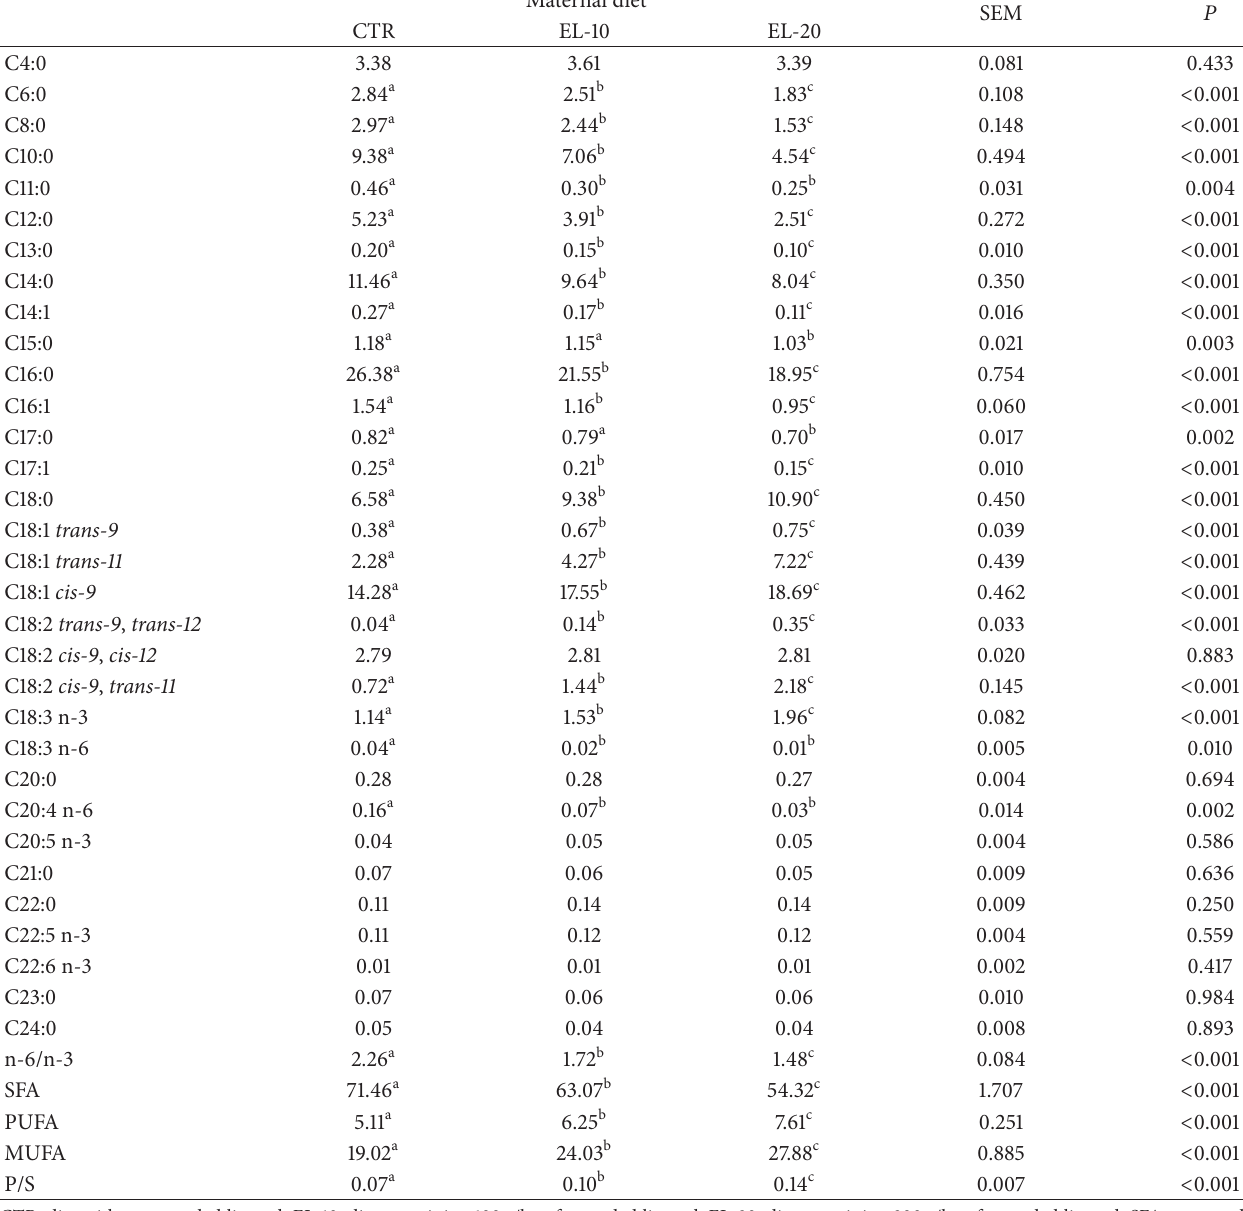
Table 2: Effect of linseed supplementation on the fatty acid profile (g/100g of total fatty acids methyl esters) of